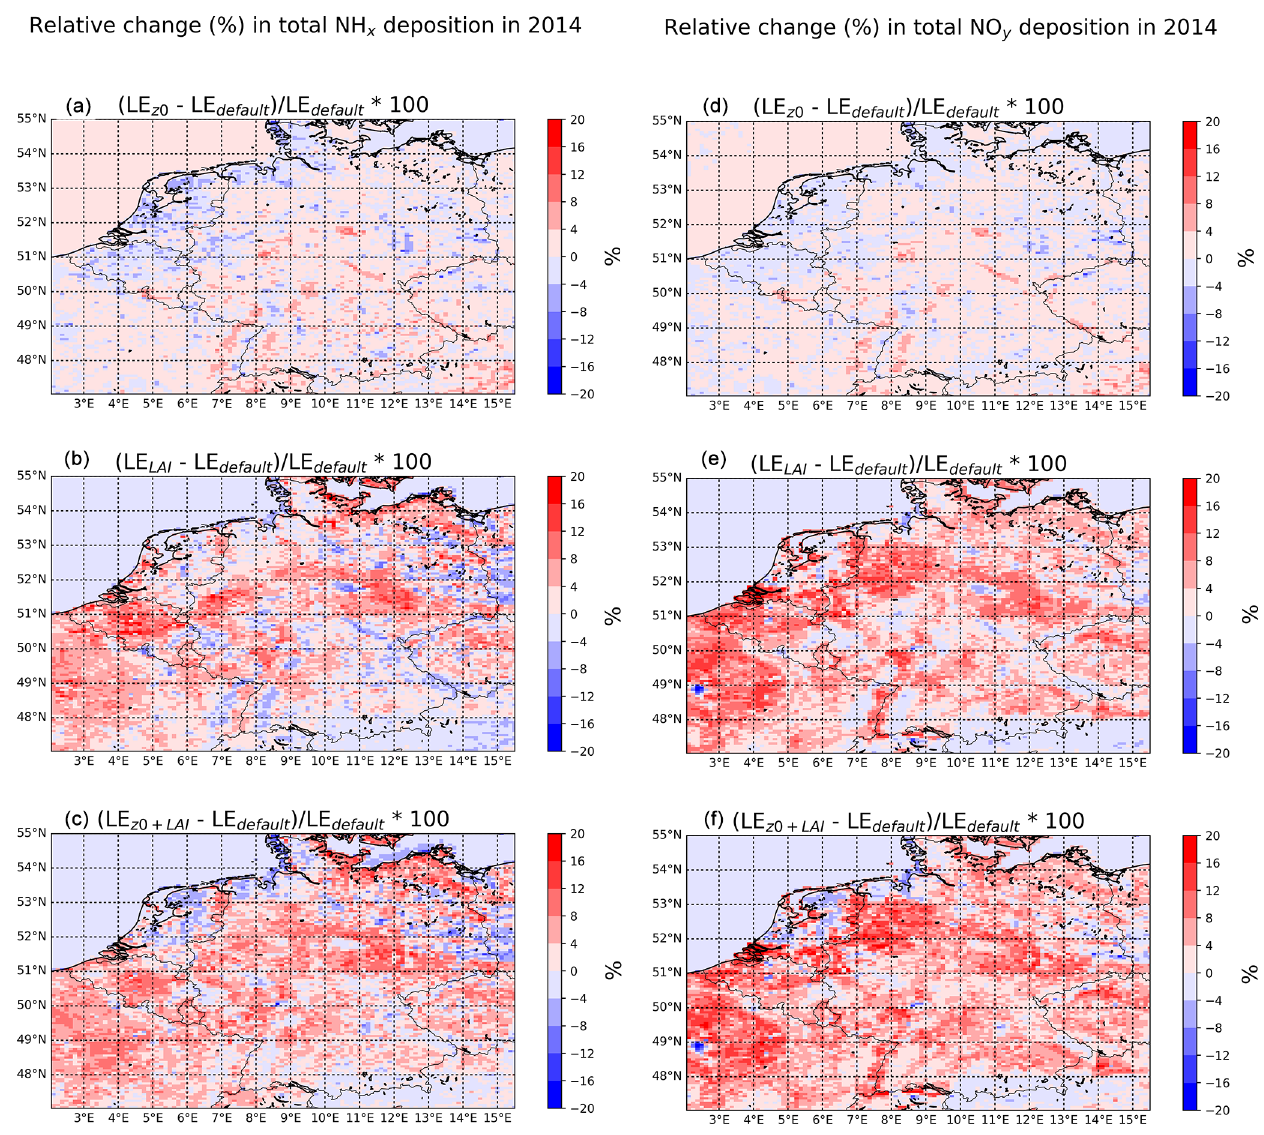
Figure 13. The relative change in total NH x (a, d) and NO y (c, f) deposition in 2014 for the different model runs relative to the default LOTOS-EUROS run. The first row indicates the changes related to the implementation of the updated z 0 values. The second row indicates the changes related to the implementation of the MODIS LAI values. The third row shows the combined effect of both these